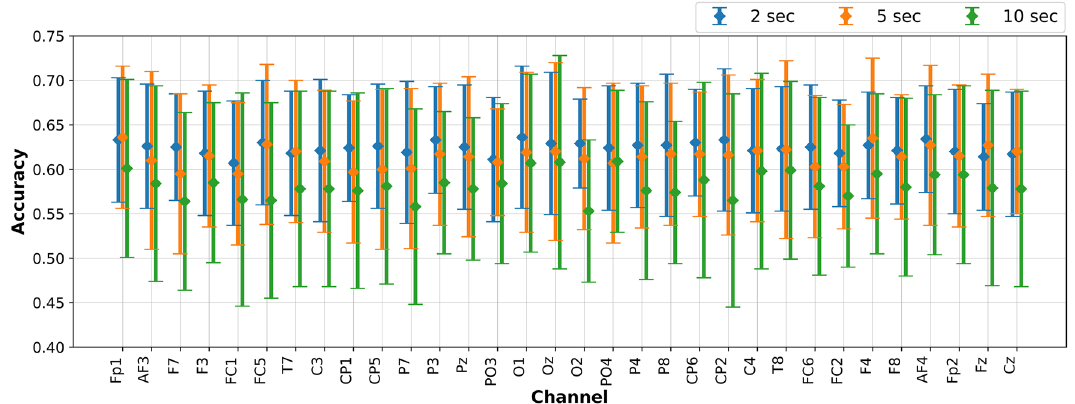
Figure 4. Low vs high arousal classification accuracies and standard deviation for the test set (25% of the data) using EEG data from one channel at a time and the EEGNet.